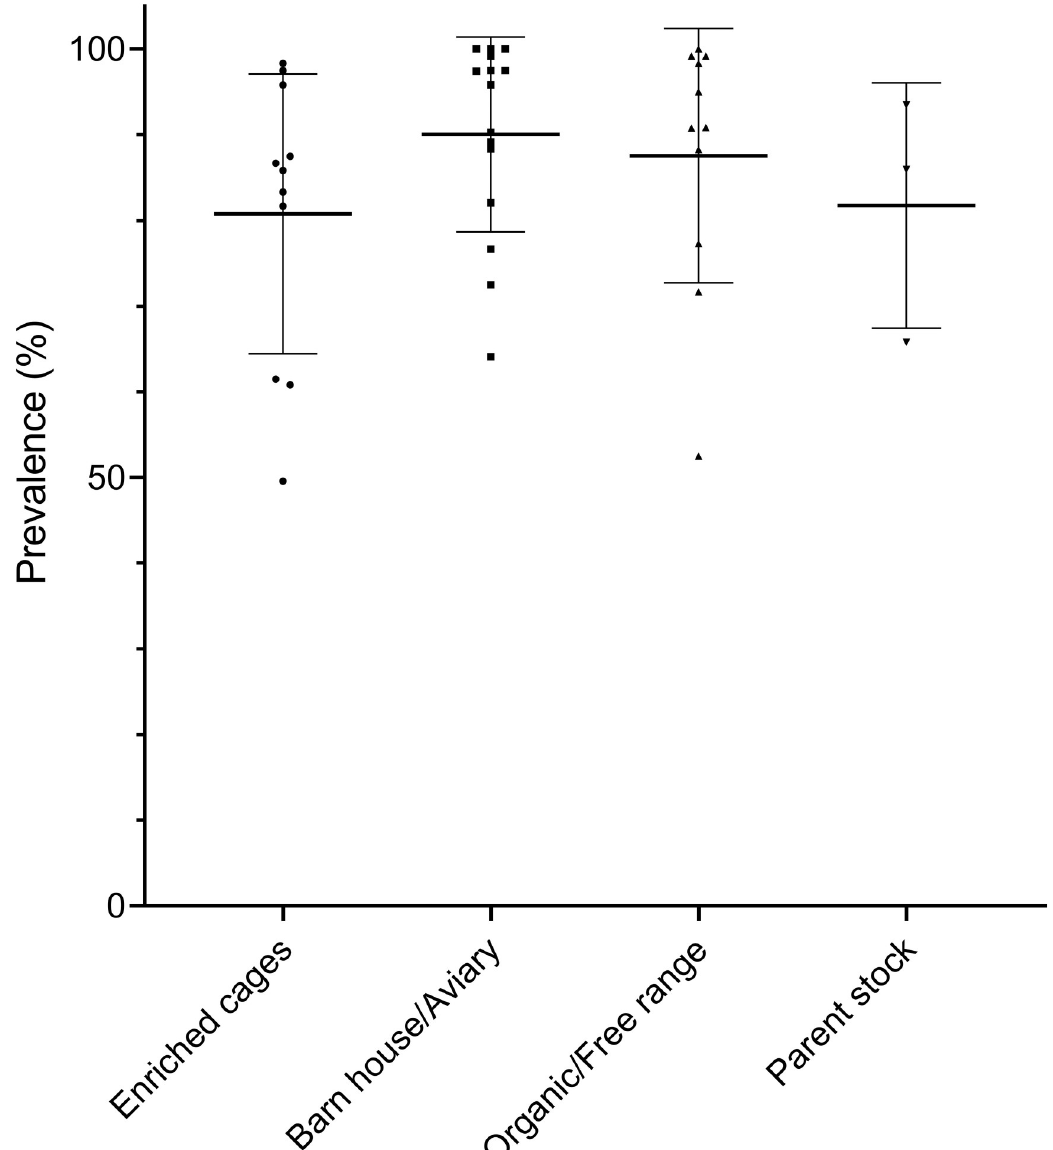
Fig 1. Scatter plot of the flock prevalence of KBF within each production system. Lines and error bars represent mean and standard deviation.